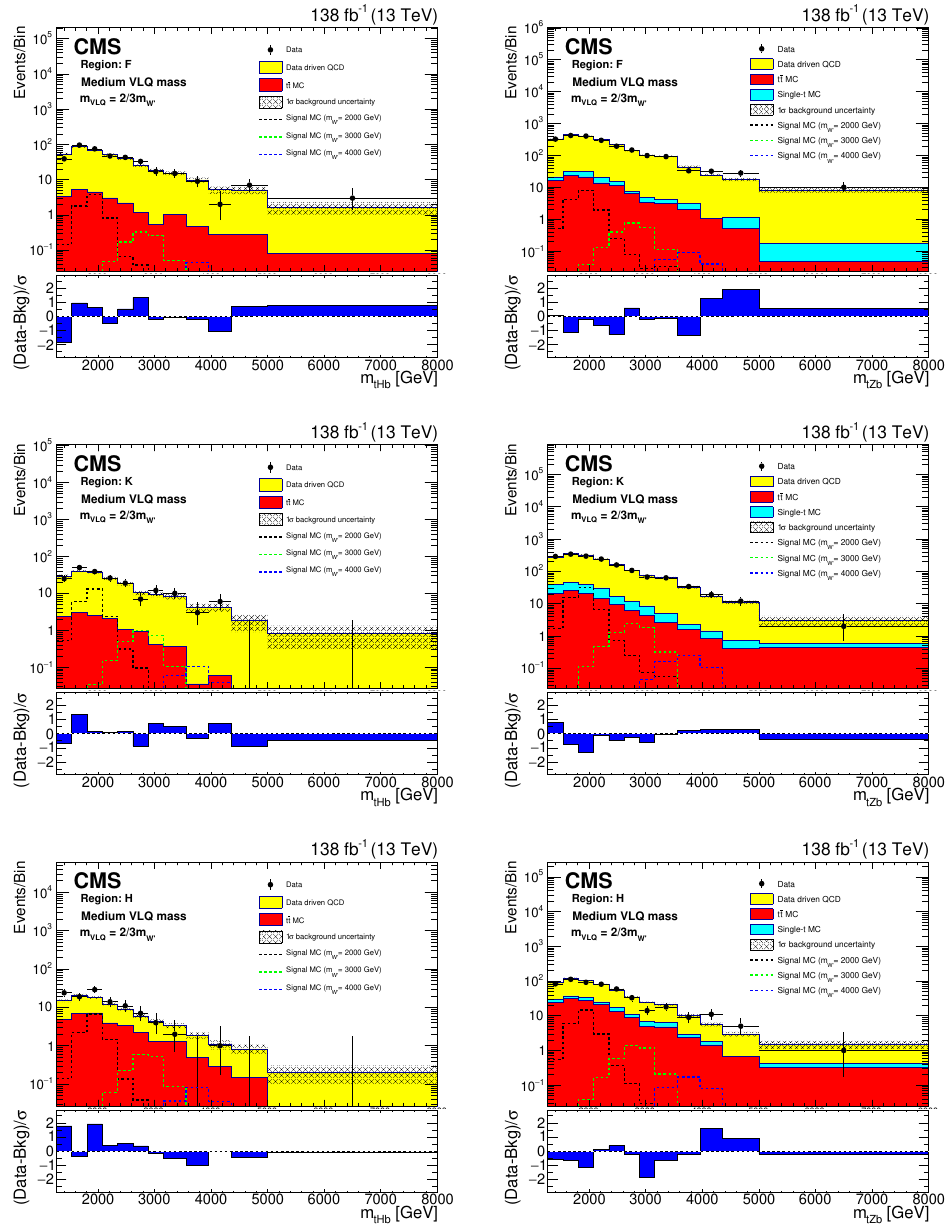
Figure 5 . Background closure test for the reconstructed W 0 boson invariant mass in region F (upper), K (middle), and H (lower) for the purpose of validation in the tHb (left) and tZb (right) analyses. The data are shown as points with error bars and the estimated backgrounds as solid histograms after a background-only fit, with a hatched band indicating the uncertainty. Expected signals for several W 0 boson mass hypotheses are shown. The lower panel of each plot shows the difference between the number of events observed in the data and the predicted background, divided by the total uncertainty in the background and the statistical uncertainty in the data added in